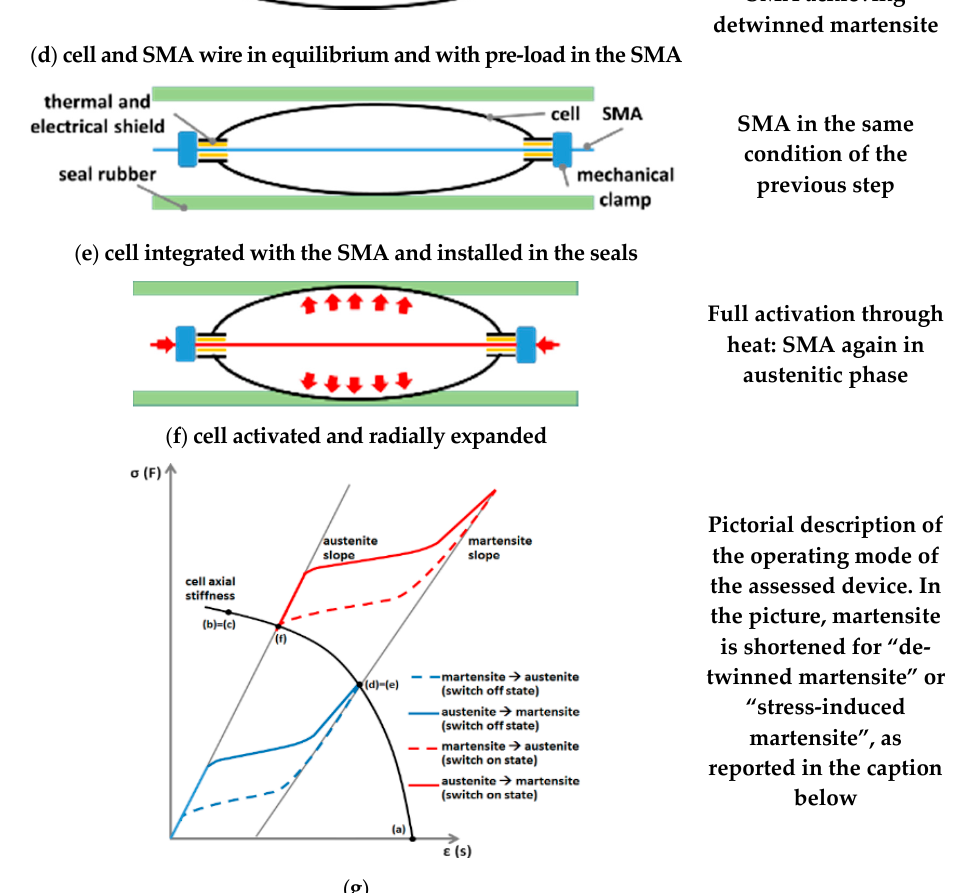
Figure 3. Integration process of the cell with the SMA wire ( a – d ), installation and activation within the seal ( e , f ), stress-strain curve comparison for the SMA and the cell vs the different integration phases ( g ). Cyclic transformation between de-twinned martensite (or stress-driven martensite) and austenite